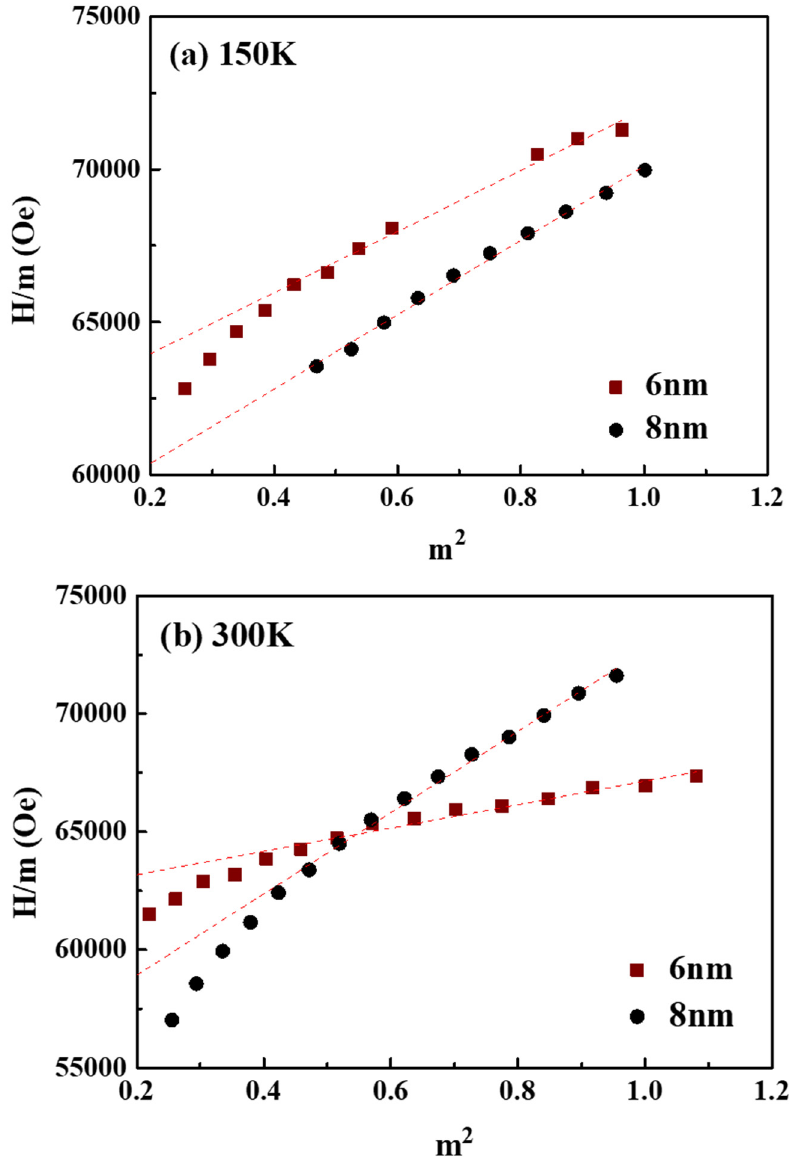
Figure 6. Analysis of the hard-axis loop according to Sucksmith–Thompson for FePt (B, Ag, C)/MoC/MgTiON/CrRu films measured at ( a ) 150 K, ( b ) 300 K.